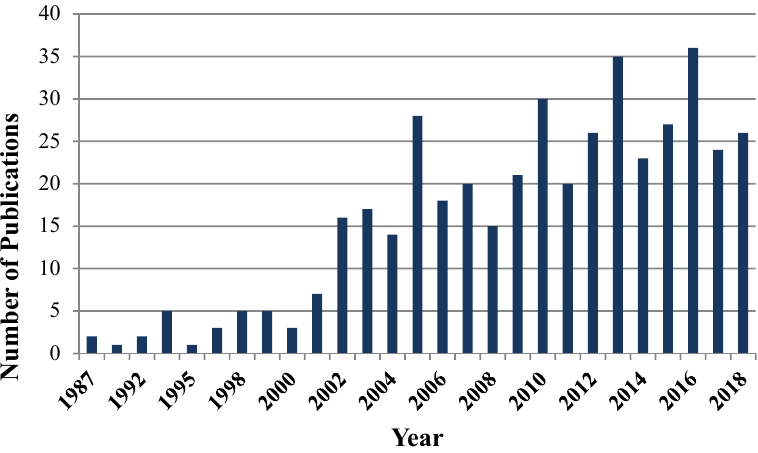
Figure 1. Publications on Crimean–Congo hemorrhagic fever virus (CCHFV). Frequency of CCHFV molecular diagnostics publications in English from 1992 to 2018.